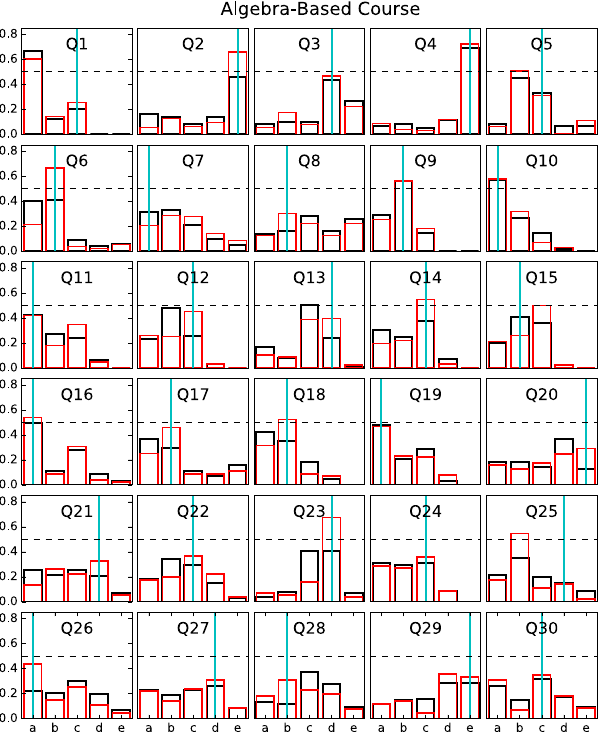
FIG. 4. EMCA question choices and answers for the algebra- based classes. Black represents the pretest selection and red represents the post-test selection. The cyan vertical line marks the correct answer. The y axis shows the fraction of the overall population that selected each choice. The dashed horizontal line marks 50% of the total number of students with matched pre- and post-test results.